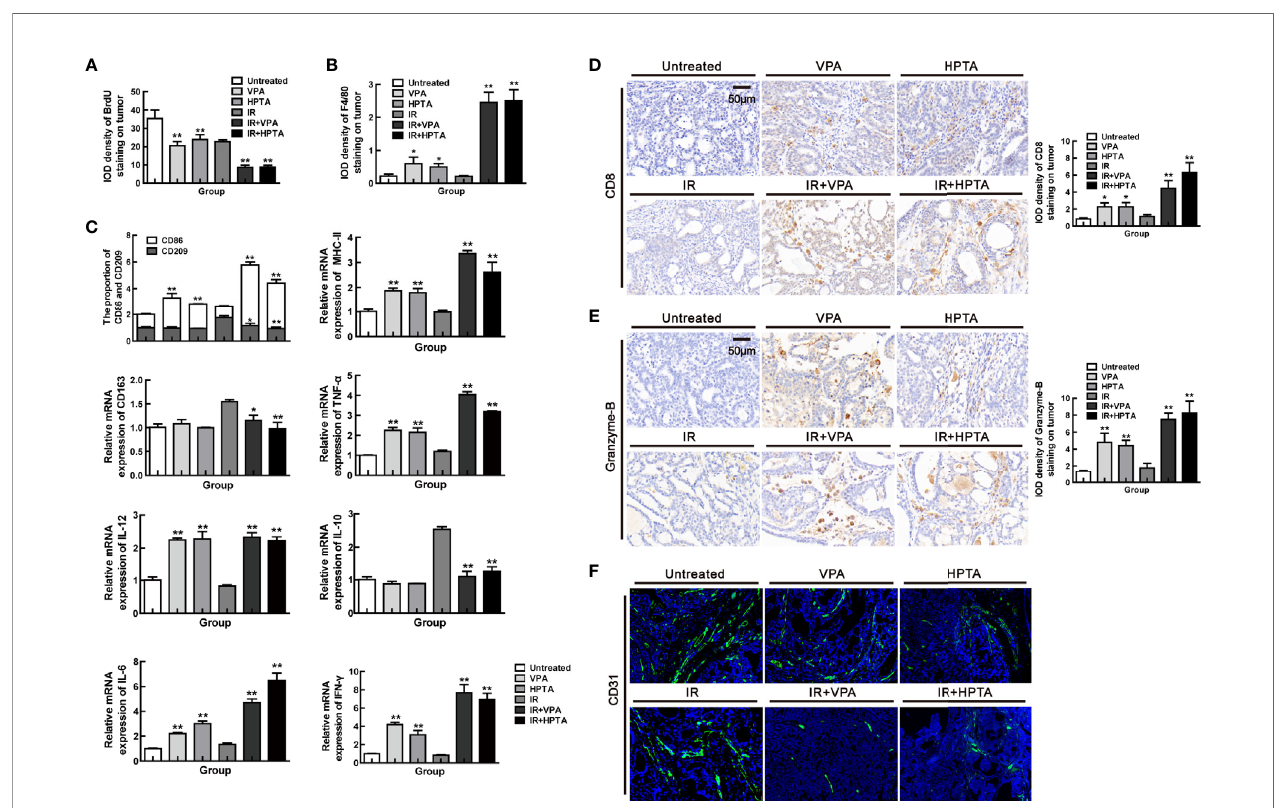
FIGURE 6 | VPA/HPTA prolong the radiotherapy effect of breast cancer via maintaining the durability of anti-tumor immune response in vivo Tumor tissues were analyzed 70 days after treatment. Quantitative analysis of BrdU (A) and F4/80 (B) immunohistochemistry. (C) The mRNA expression levels of CD86, CD209, CD163, MHC-II, IL-10, TNF- a , IFN- g , IL-6 and IL-12 in DMBA-induced breast tumors in rats were determined by real-time PCR. Data were normalized to the untreated group. (D) IHC was performed on tumor sections for the marker CD8. Quantitation as a percentage of total tissue is shown to the right of representative images. (E) IHC was performed on tumor sections for the marker granzyme-B. Quantitation as a percentage of total tissue is shown to the right of representative images. (F) Immuno fl uorescence staining of tumor vessels (CD31+: green) and representative images are shown. Each data point in the graphs was from three independent experiments (mean ± SD). P -values were calculated by Student ’ s t-test (* P < 0.05, ** P <